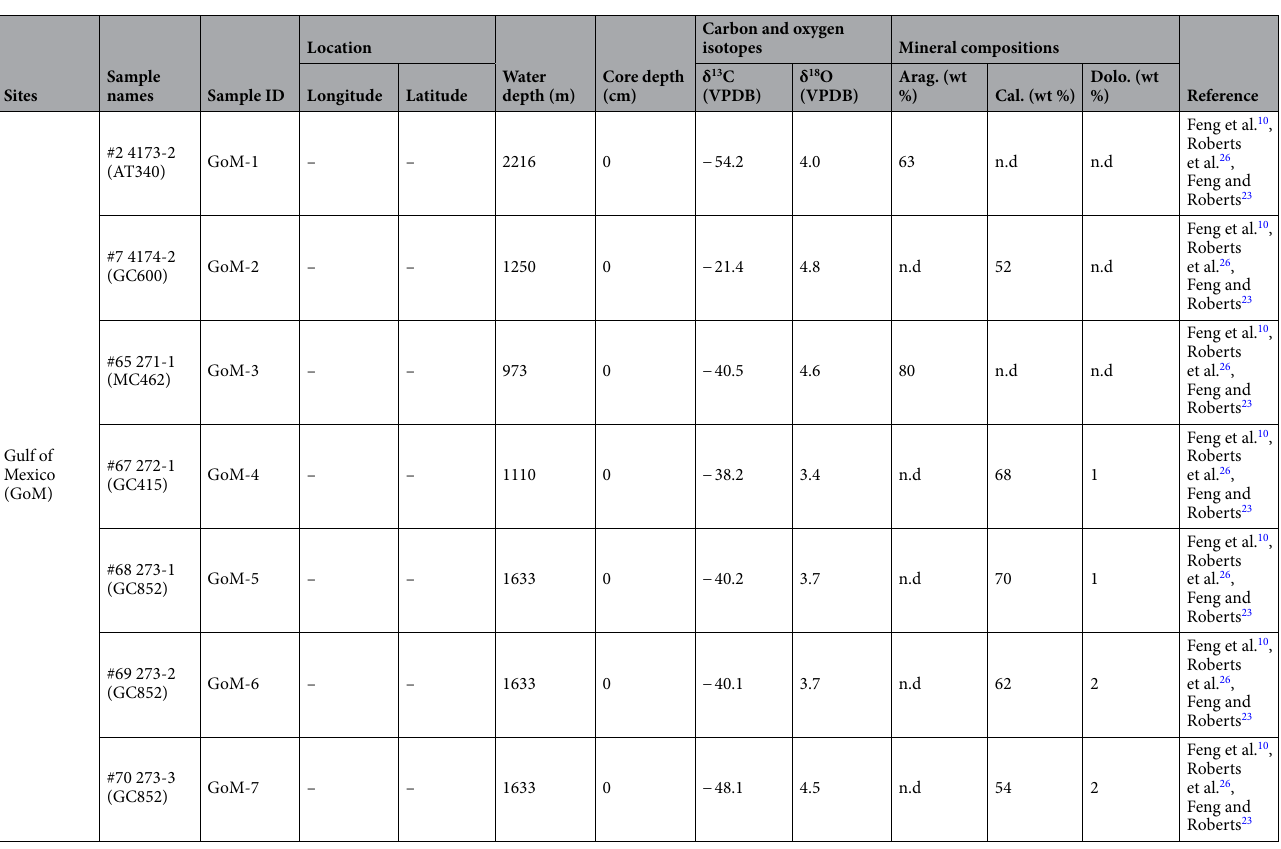
Table 1. Site information and mineral and stable isotopic compositions of authigenic carbonate samples considered in this study. n.d. denotes ‘not determined’. ‘–’ indicates ‘not